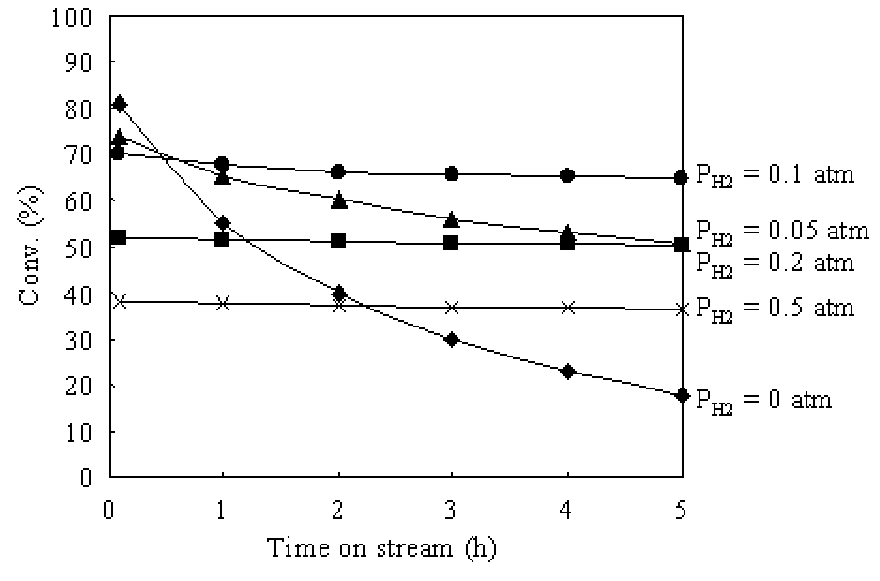
O +Cs2.5 at 573 2 3